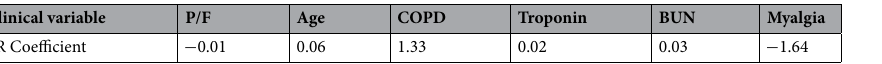
Table 6. Logistic regression coefficients after leave-one-out cross validation with the clinical variables selected by the GA on the first wave dataset (Table 3, F1-score 0.899, Accuracy 0.903).